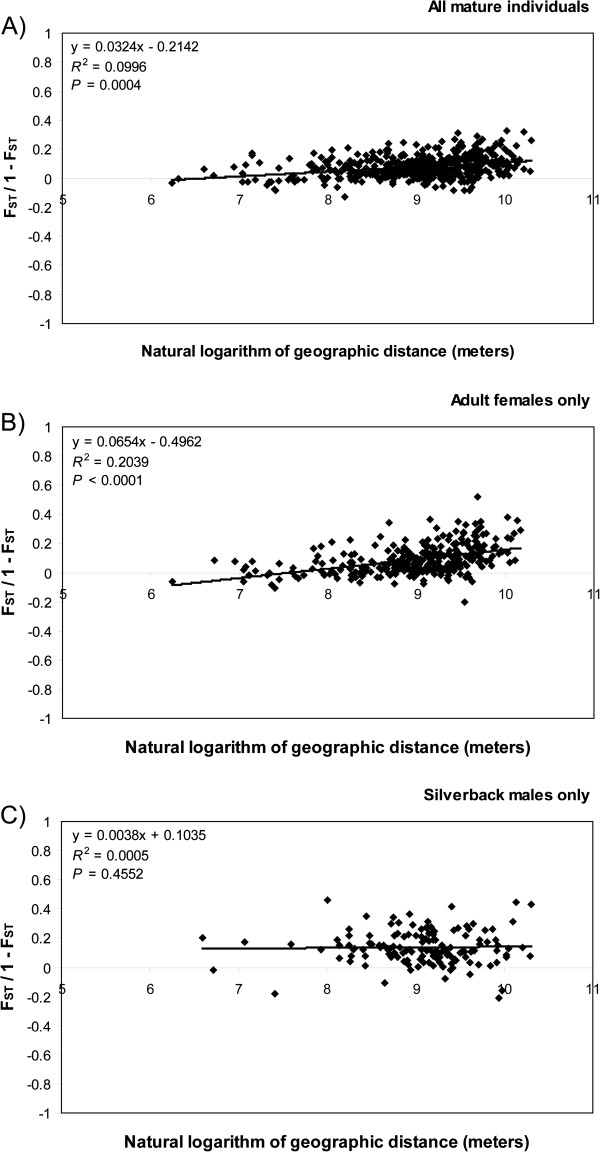
Linear regression between pairwise FST/(1 – FST) ratios and the natural logarithm of geographic distance separating two groups. Only groups containing two or more individuals were used in the analyses. (A) All mature individuals (n = 32 groups); (B) Adult females only (n = 25 groups); (C) Silverback males only (n = 17 groups). Regression lines are displayed for each plot. The regression equation, the coefficient of determination (R2), and the probability (P) to obtain a regression slope higher than the one observed are also reported. Note the identical scale for all plots.